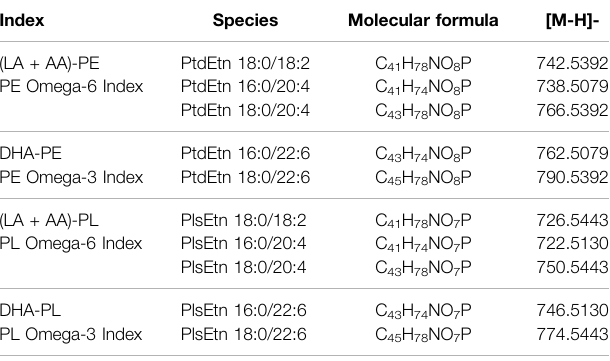
TABLE 1 | Ethanolamine phospholipid indices.